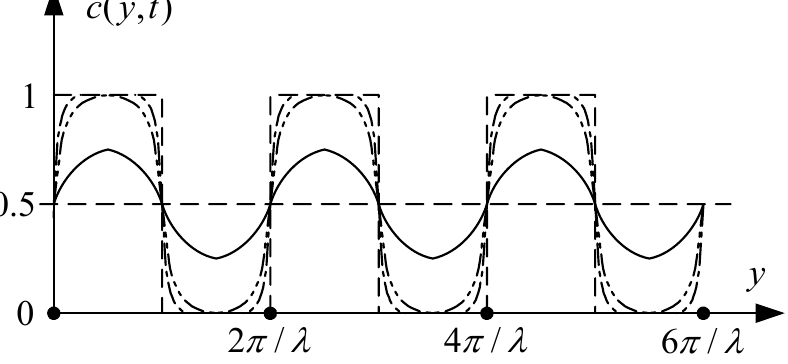
Figure 4. Schematic of the two-stage development of concentration distribution along the cross-section of the channel in the one-dimensional diffusion model for the hydrodynamic focusing method; the dashed, dash-dot and dash-dot-dot lines depicts the first stage while the solid line is for the second